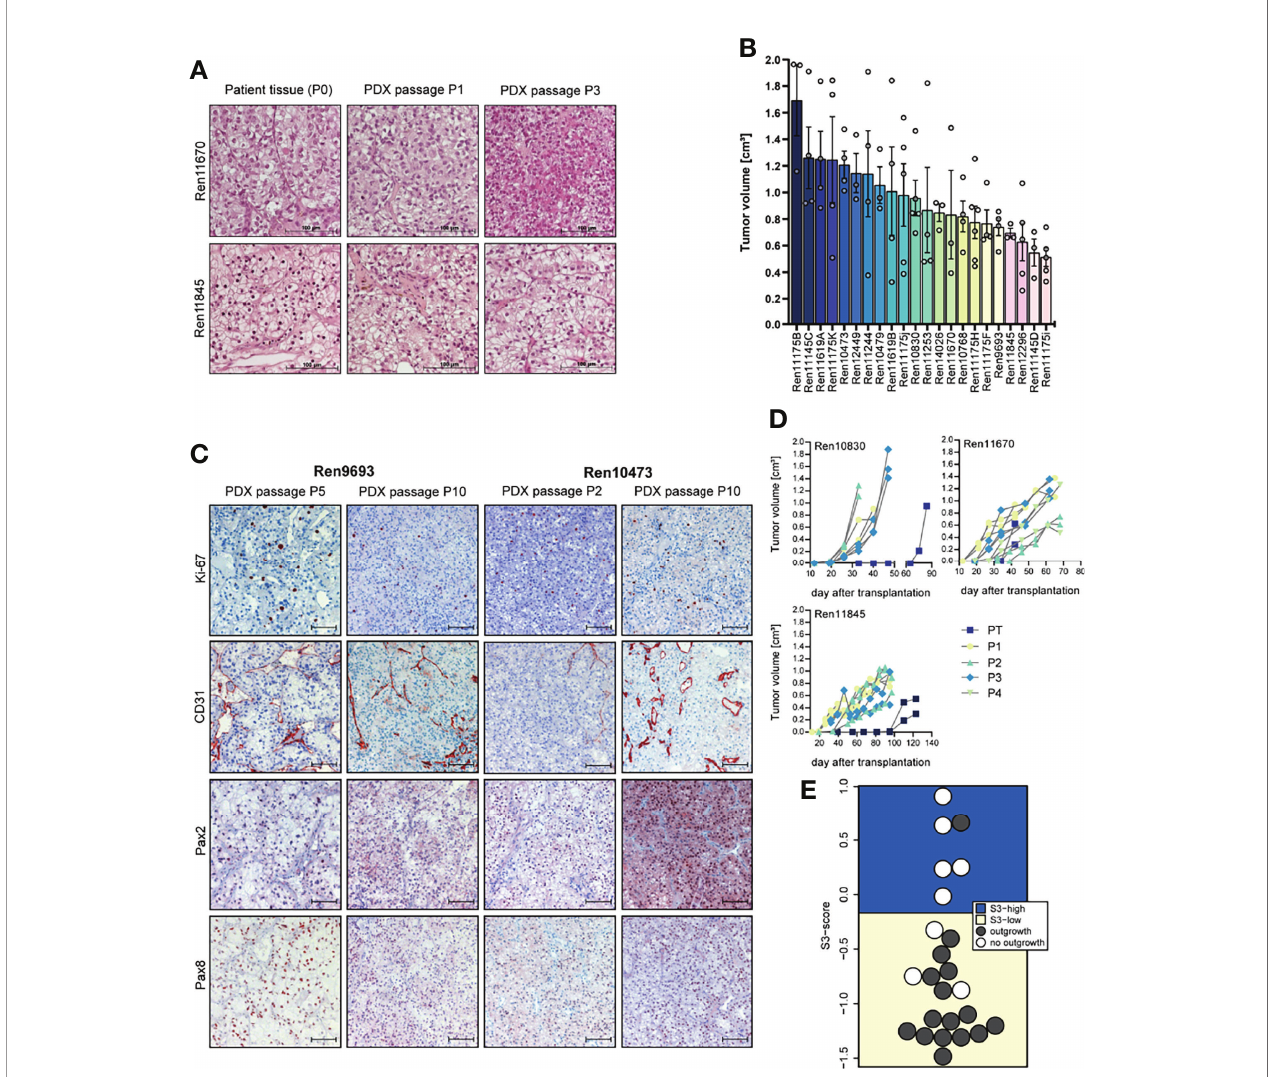
FIGURE 1 | Histopathology, tumor growth characterization, and immunostainings (IHC) of representative PDX models from the RCC PDX panel. (A) Histological examination of patient and PDX tissue from the fi rst (P1) and third (P3) PDX in vivo passage. FFPE tissue was used for 5-µm sections and standard H&E stainings. (B) Tumor growth characteristic of untreated control mice re fl ecting the heterogeneous biology of RCC regardless of the molecular phenotype. Data from twenty-two RCC PDX models utilized for drug testing studies as mean TV ± SEM, n = 3 – 6. (C) Representative IHC analyses from RCC in vivo passaged PDX tumors for Ki-67 (proliferation), CD31 or PECAM1 (blood vessels), and Pax2 and Pax8 (renal marker). The brown staining indicates the positivity for the respective markers within the tissue. Scale bar = 100 µm. (D) Exemplary RCC PDX growth curves showing individual TV growth characteristic during in vivo passaging (PT = primary tumor passage, P1 – P4 indicate consecutive PDX tumor passages). (E) The gene expression-based ccRCC risk model (S3 score) was calculated for primary tumors and metastases from tissue of the Tübingen cohort collected for PDX generation. In 16 of the 24 cases shown, the PDX establishment was successful. The